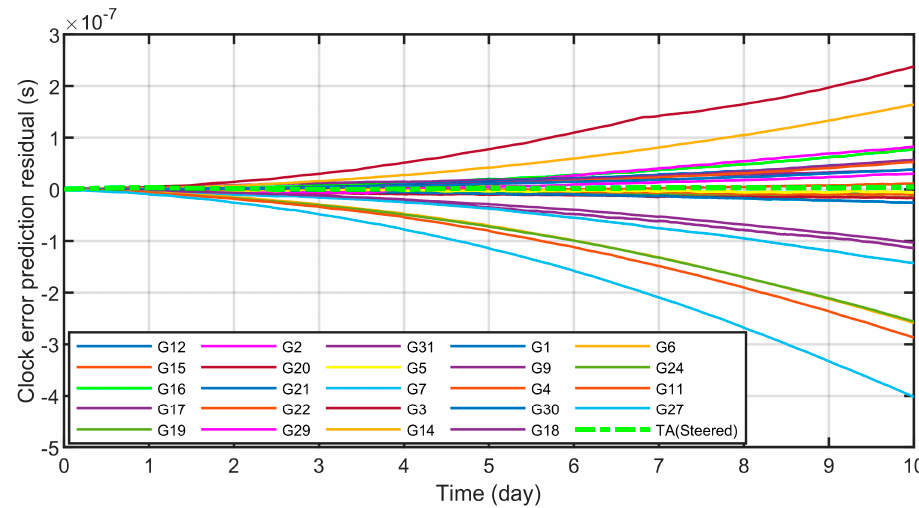
Figure 17. The forecast error of TA(Steered) and 24 atomic clocks.